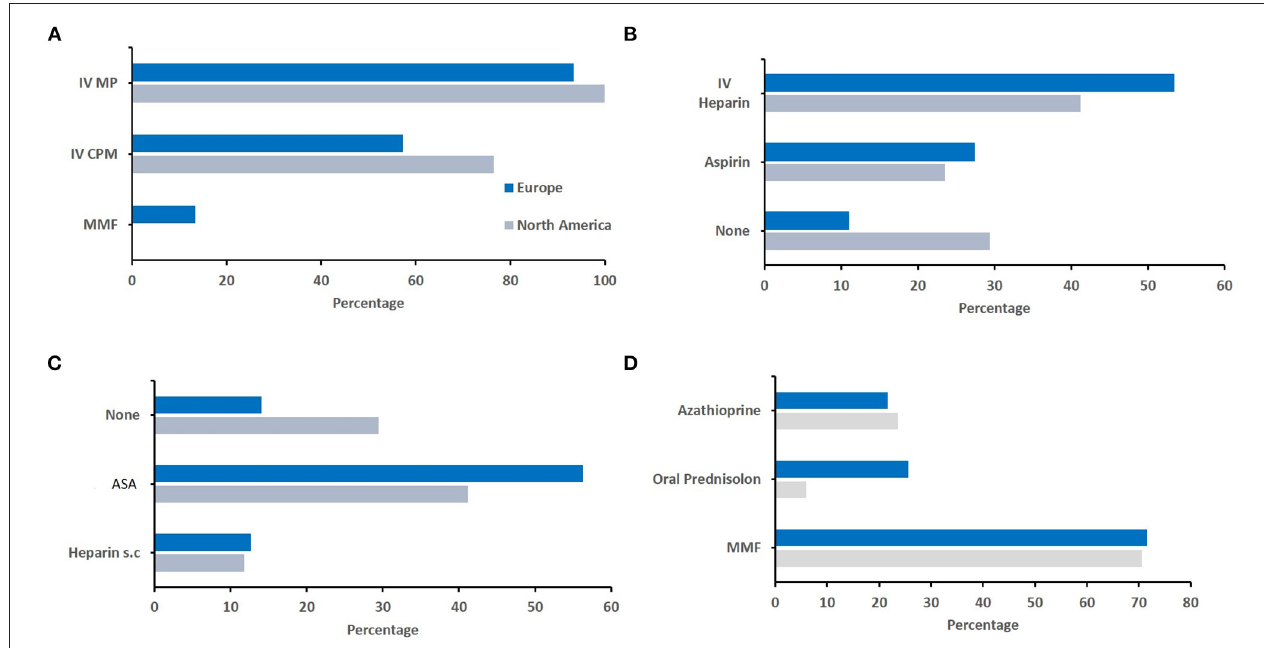
FIGURE 5 | Geographical differences in therapeutic approaches. Responses were compared between responddents from Europe and North America. (A) Immunomodulating induction treatment (North America N = 17, Europe N = 75). (B) Acute anticoagulation treatment (North America N = 17, Europe N = 73). (C) Post-acute anticoagulation maintenance treatment (North America N = 17, Europe N = 71). (D) Immunomodulating maintanence treatment (North America N = 17, Europe N =